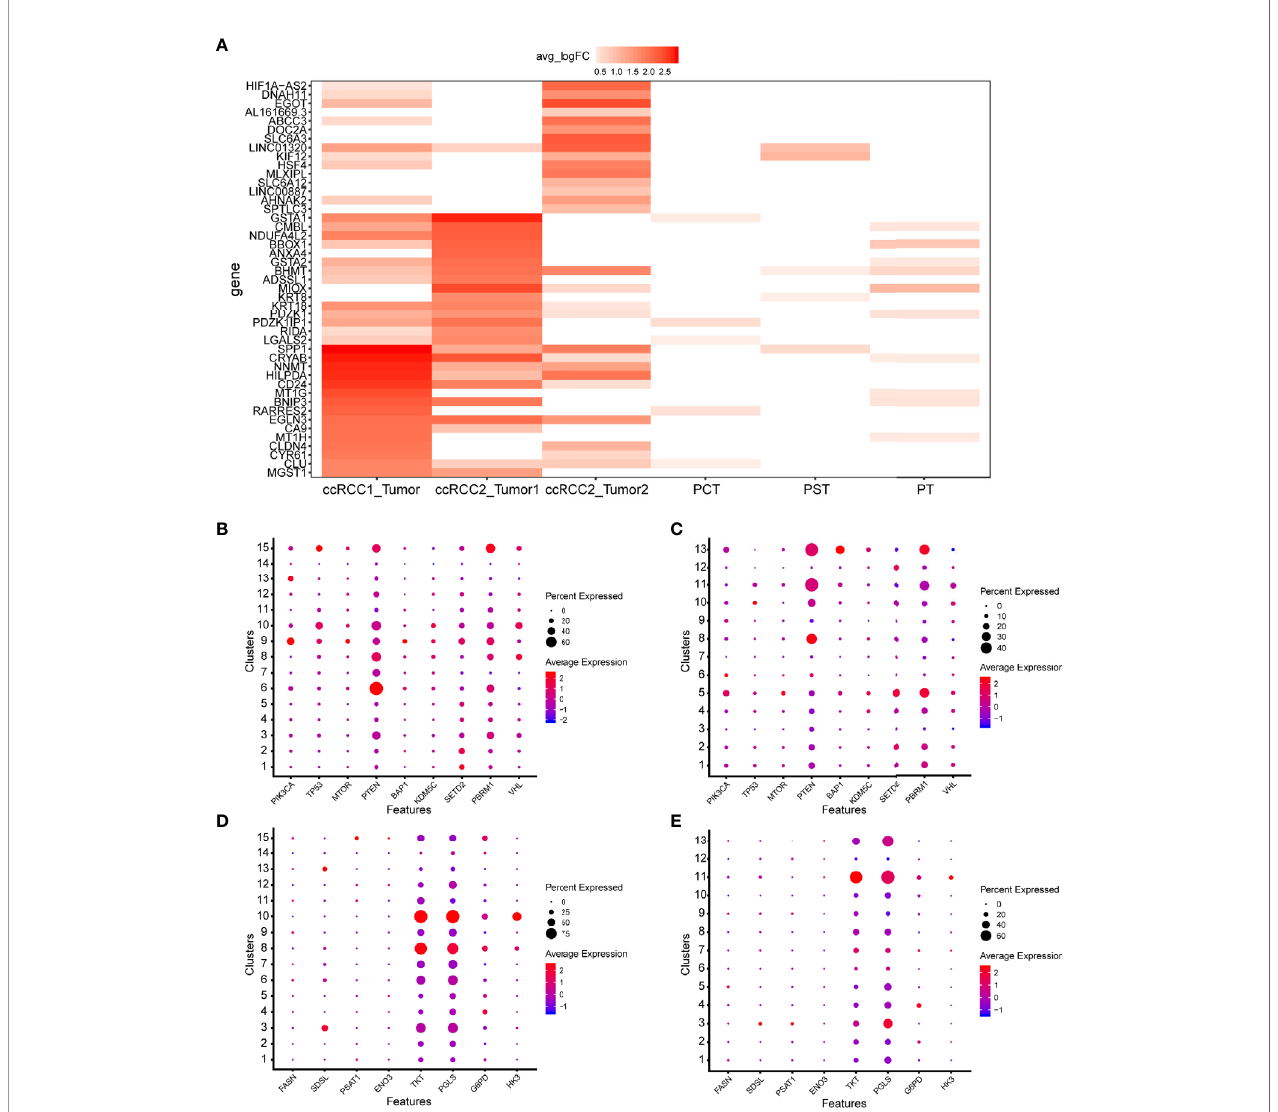
FIGURE 6 | ScRNA-seq revealed the cellular molecular characteristics of bilateral ccRCC. (A) Comparison of DEGs in different types of tumour and normal kidney cells. Proximal convoluted tubule cells (PCT), proximal straight tubule cells (PST), proximal tubule cells (PT). (B, C) Expression of common mutated genes in ccRCC1 and ccRCC2. (D, E) Expression of metabolism related genes in ccRCC1 and